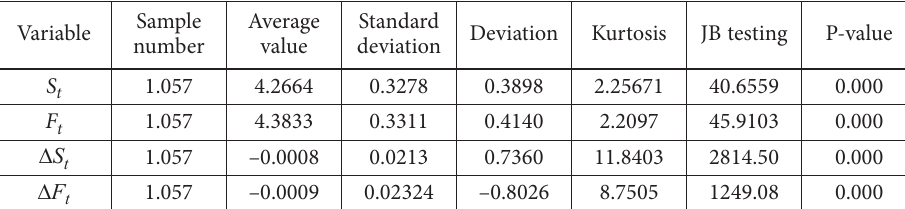
Table 5. Futures and spot price and statistics of one order